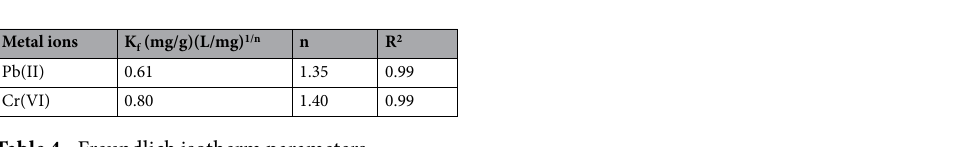
Table 4. Freundlich isotherm